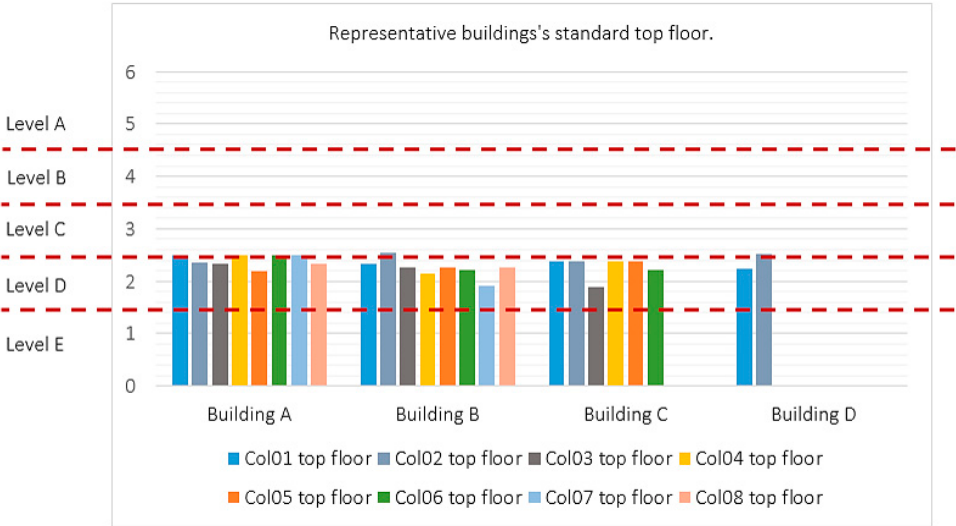
Figure 9. Final classification of the HU (standard top floor) with the water heating system.